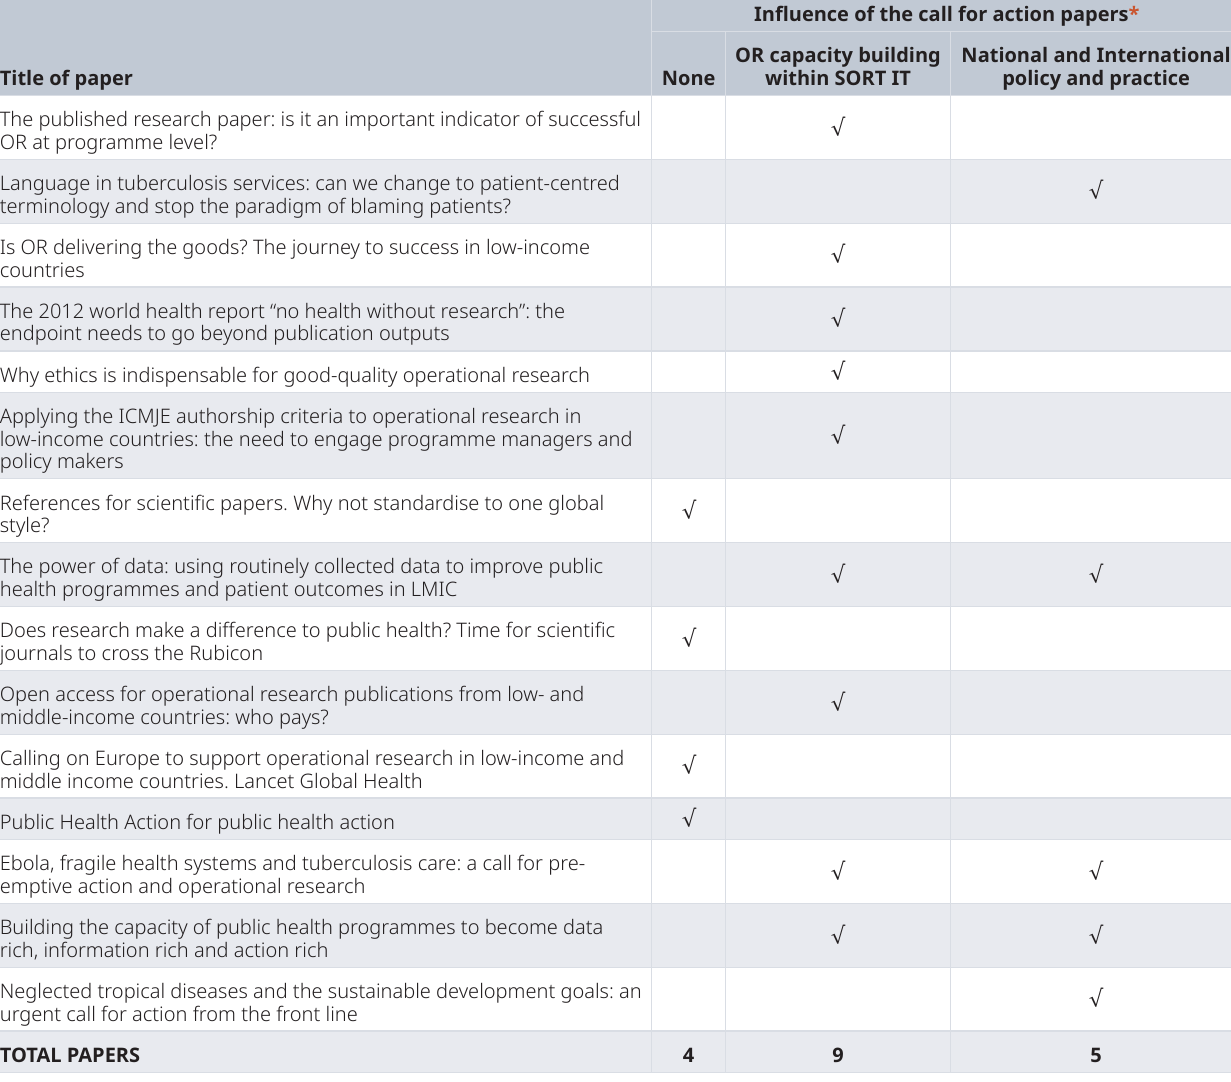
Table 3. Influence of SORT IT ‘call for action’ papers on OR capacity building and on national and international policy/practice